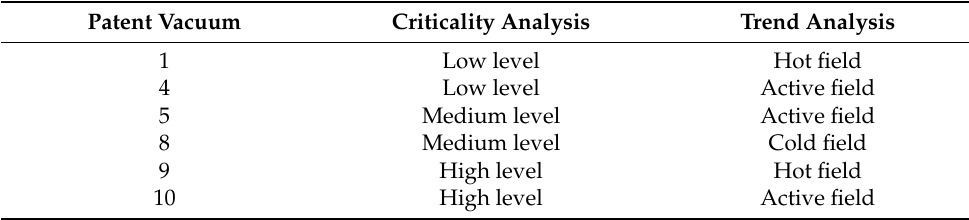
Table 5. Summary of technical analysis in the vacant technology